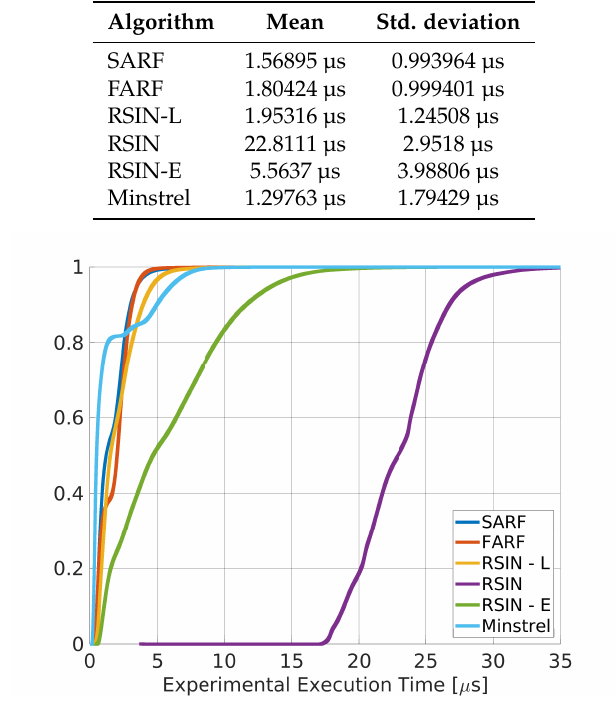
Figure 4. ECDFs for the comparison of the RAAs execution times.